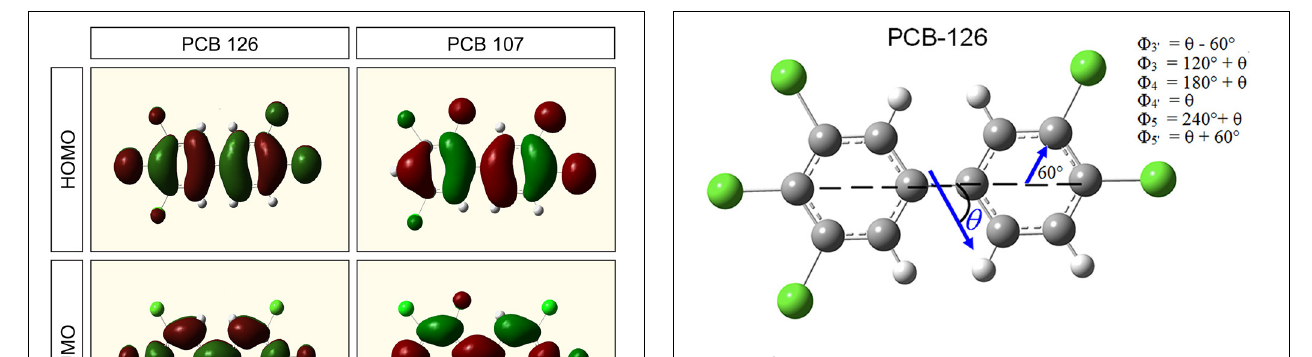
FIGURE 4 | Direction of dipole moment. PCB-126, showing direction of dipole moment (DM), relative to center axis of molecule ( θ ). θ is defined as clockwise the below center axis, 0 ◦ < θ < 360 ◦ . The DM in this example preferentially allows more active para and meta sites to attach to